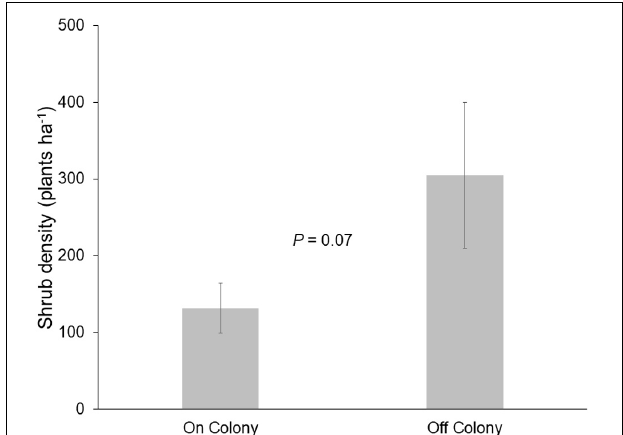
FIGURE 1 | Mean ( ± SE) density of shrubs ( Prosopis velutina and Acacia greggii ) on and off of black-tailed prairie dog ( Cynomys ludovicianus ) colonies ( n = 6; two surveys at three